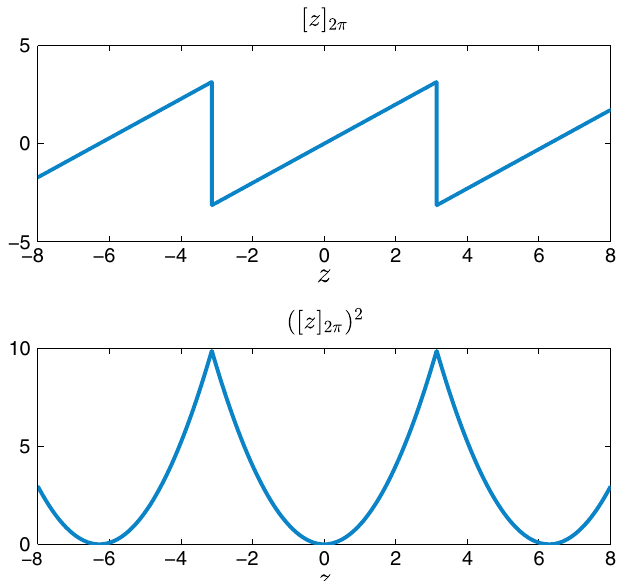
FIG. 7. Top panel: The modulo function ½ z (cid:2) 2 π . Bottom panel: Square of the modulo